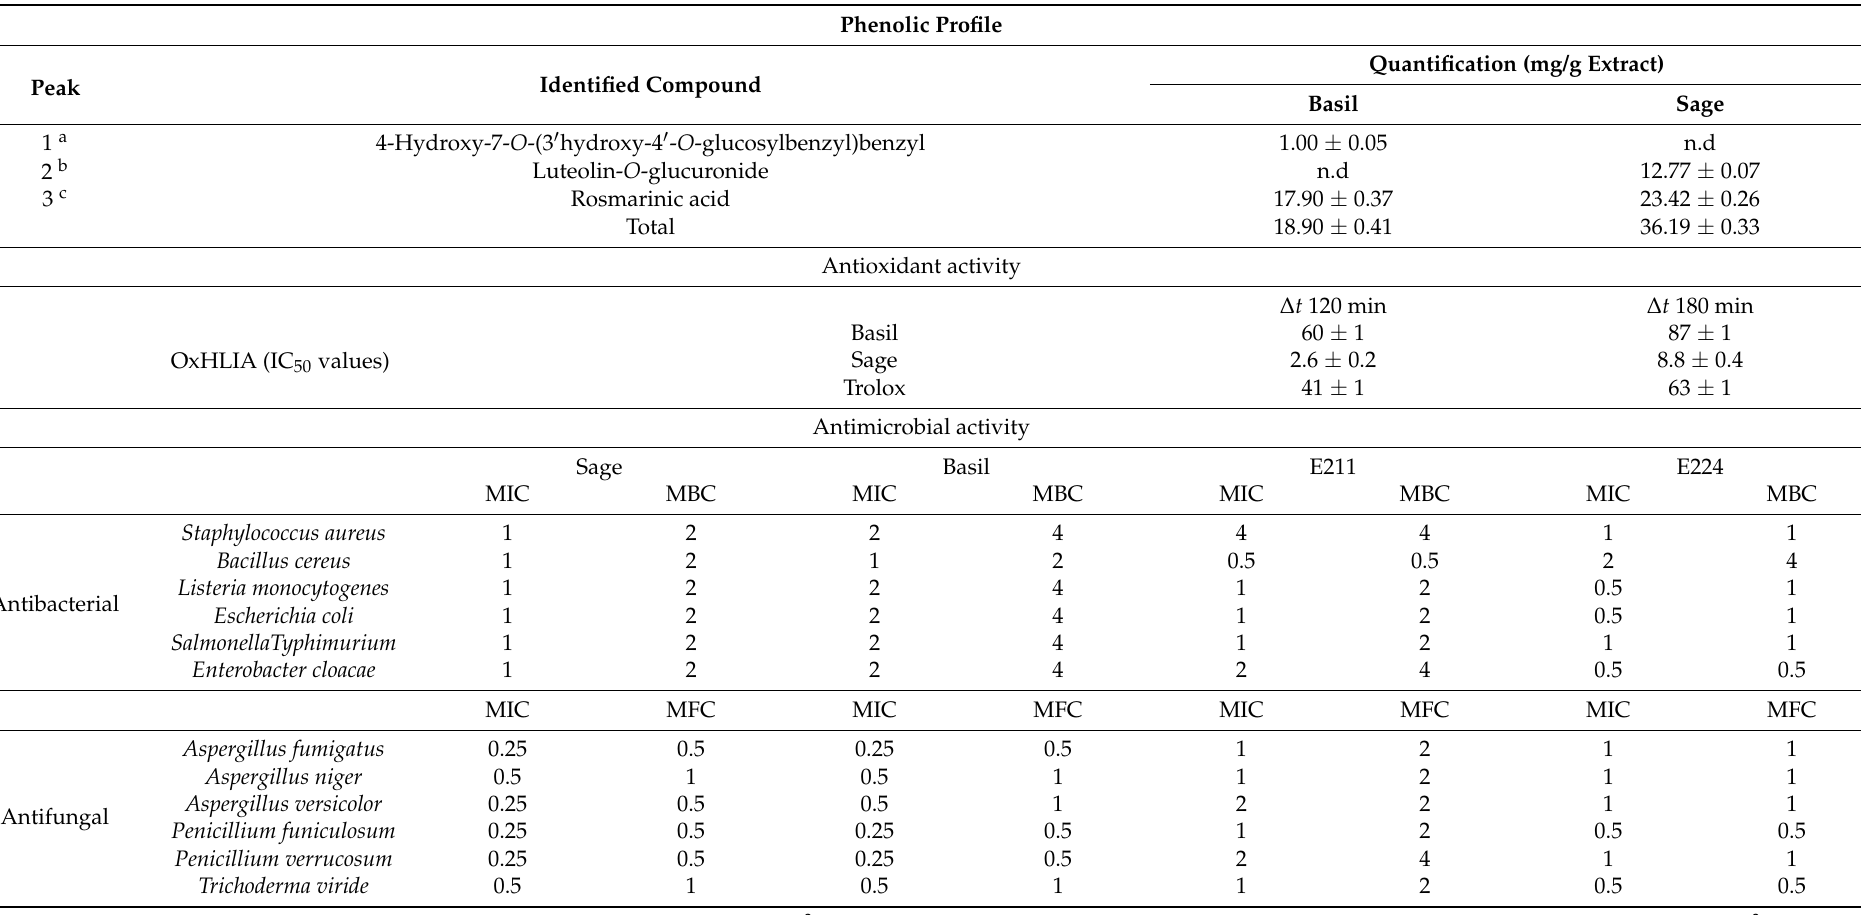
Table 1. Phenolic profile, antioxidant ( µ g/mL) and antimicrobial activity (mg/mL) of the plant